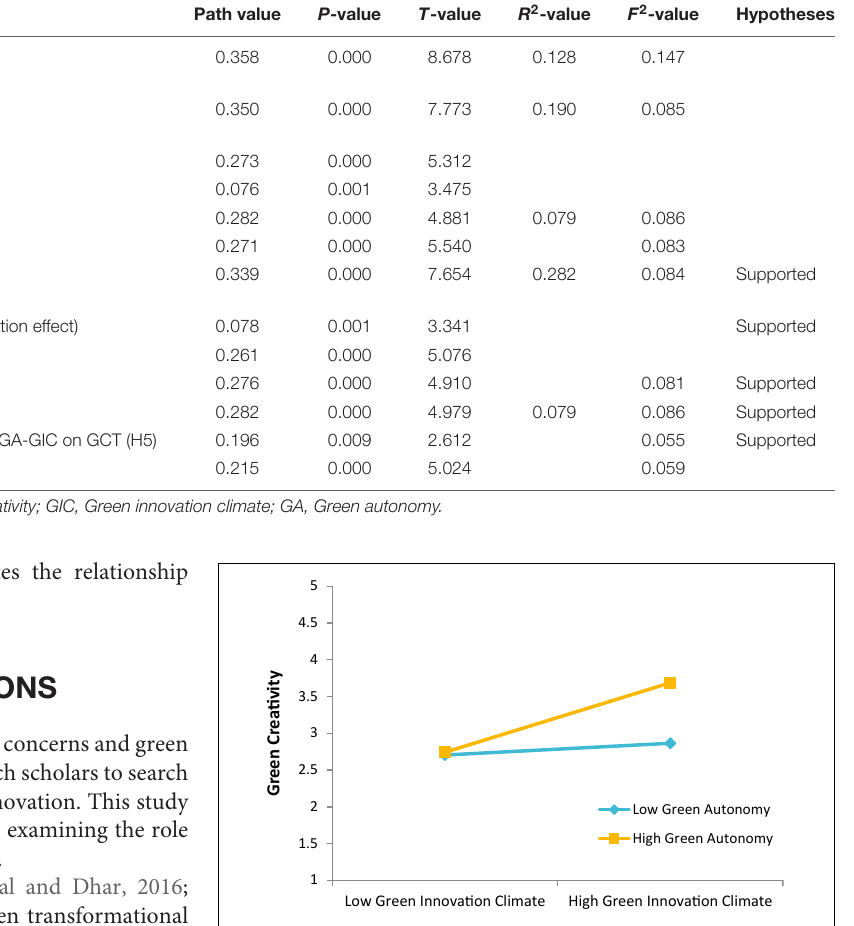
FIGURE 2 | Two-way interaction